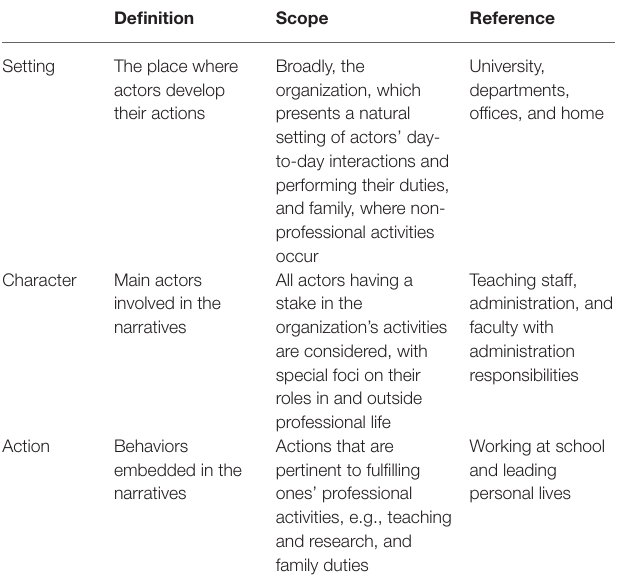
TABLE 2 | Coding fantasy